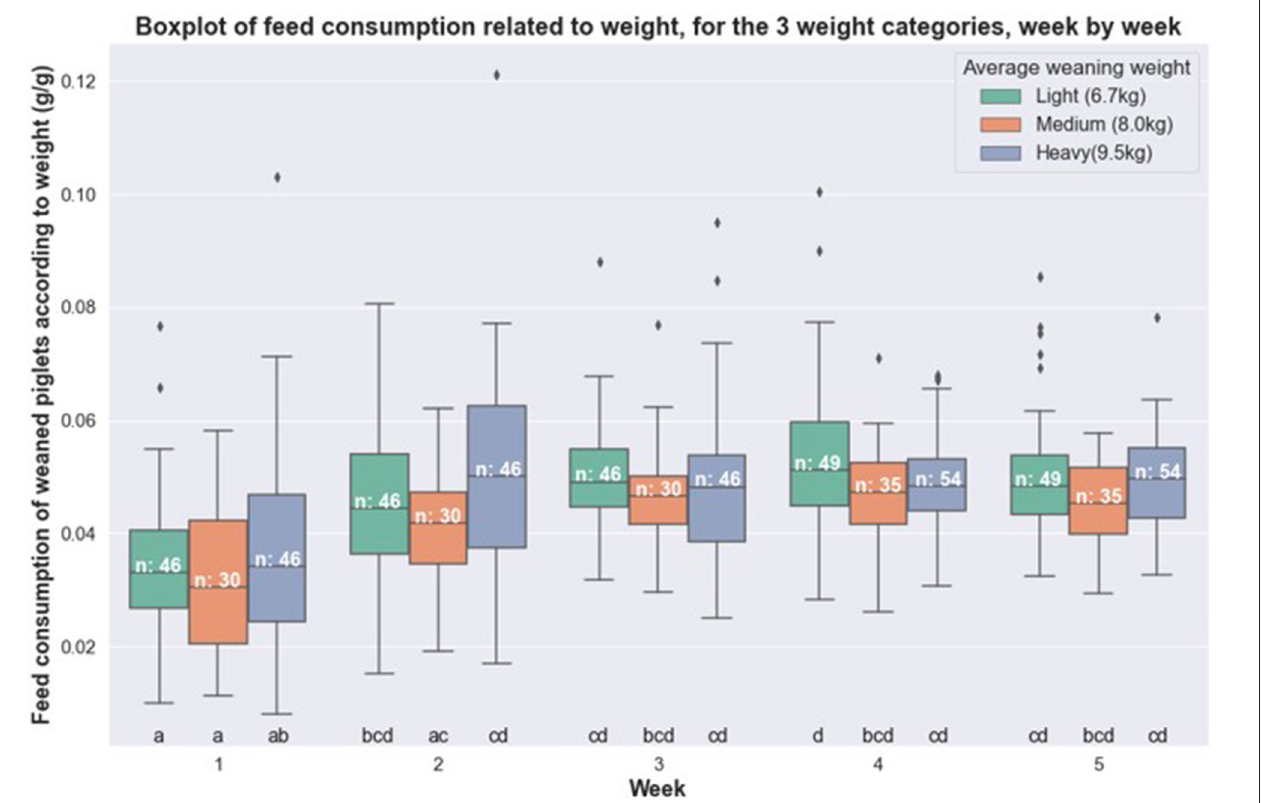
FIGURE 1 | Boxplot of feed consumption related to weight for healthy piglets, week by week, according to their weight category (light, medium and